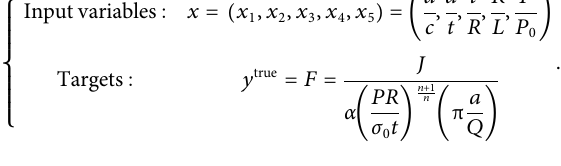
FIGURE 9 Result of the (5-64-256-64-1) BPNN.